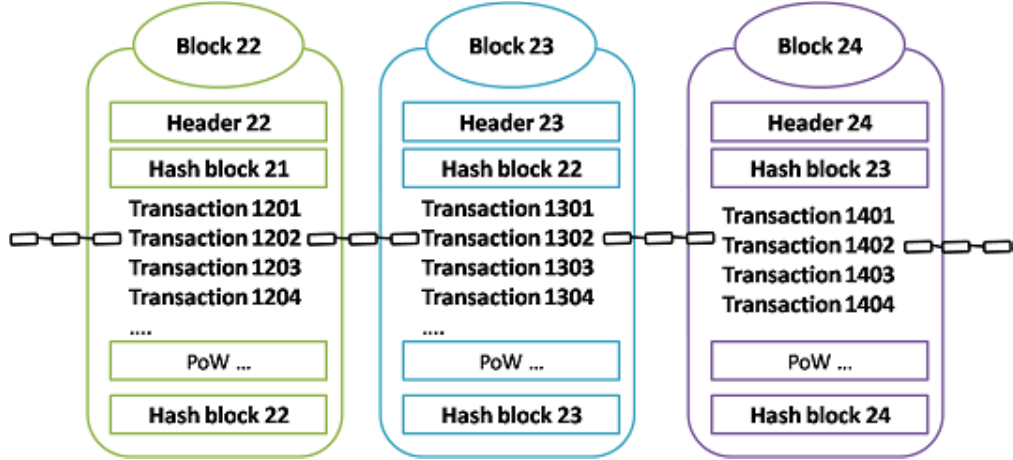
Figure 4. A blockchain